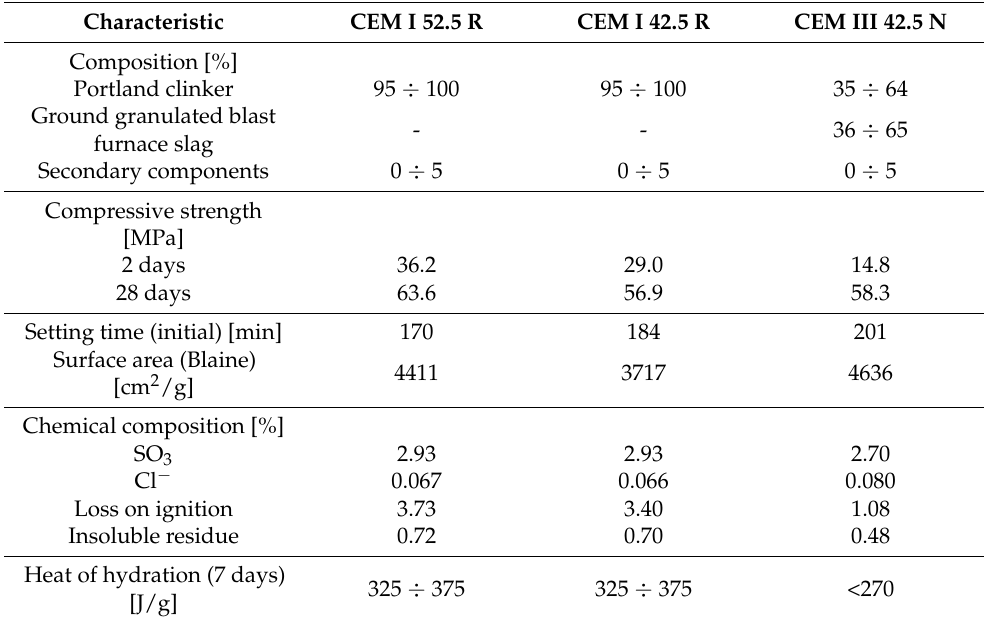
Table 1. Properties of cements used in the